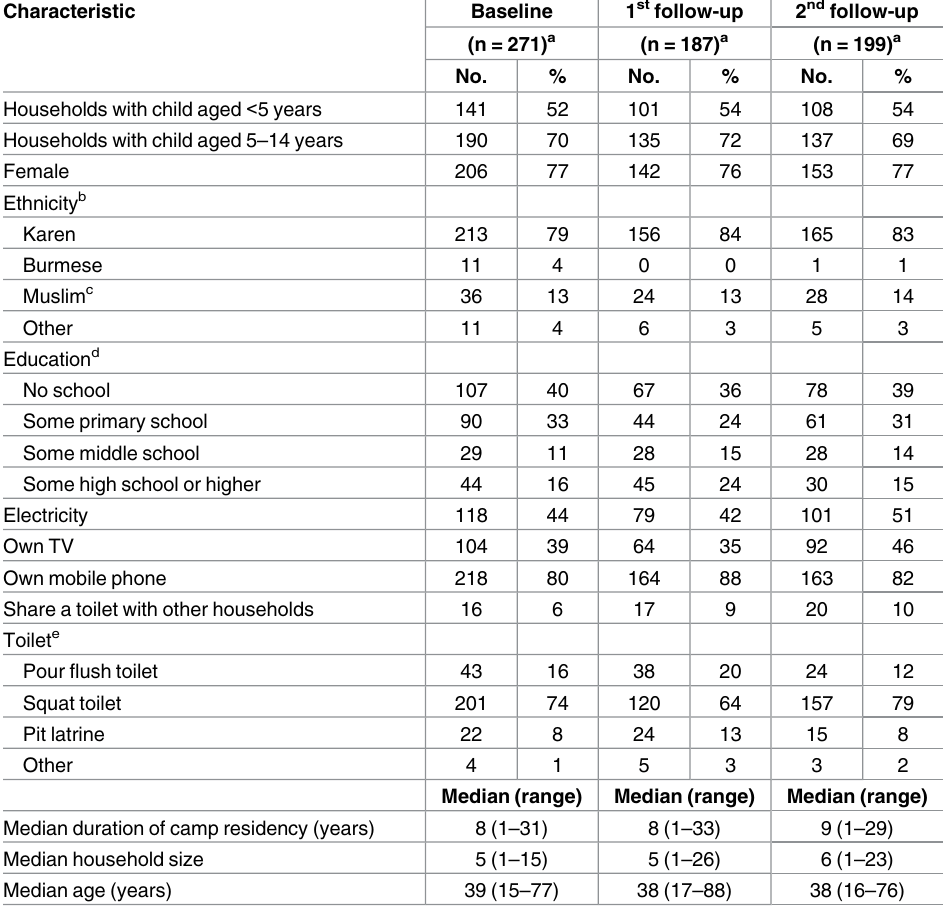
a Missing data resulted in small fluctuations in denominators for some responses b For statistical analysis, ethnicity was computed as a binary outcome (Karen vs. non-Karen) c In the camp, "Muslim" is a widely identified ethnicity, in addition to being a religion d For statistical analysis, education was computed as a binary outcome (some school vs. no school) e For statistical analysis, toilet was computed as a binary outcome (pour flush and squat toilet vs. pit latrine and